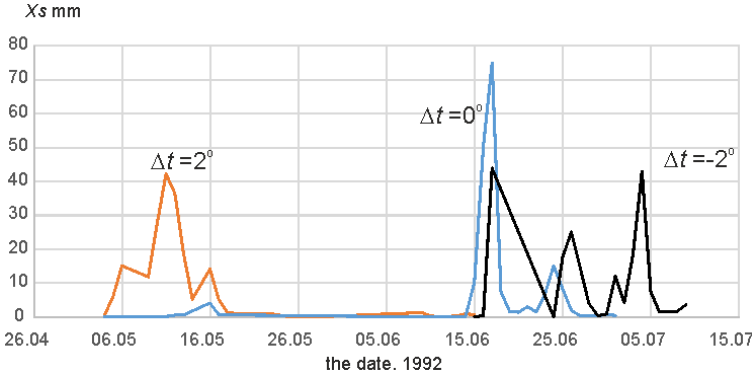
Figure 15. Changes in shape of hydrograph of daily runoff during the snow thaw period with variations of daily air temperatures, an example for 1992 year.